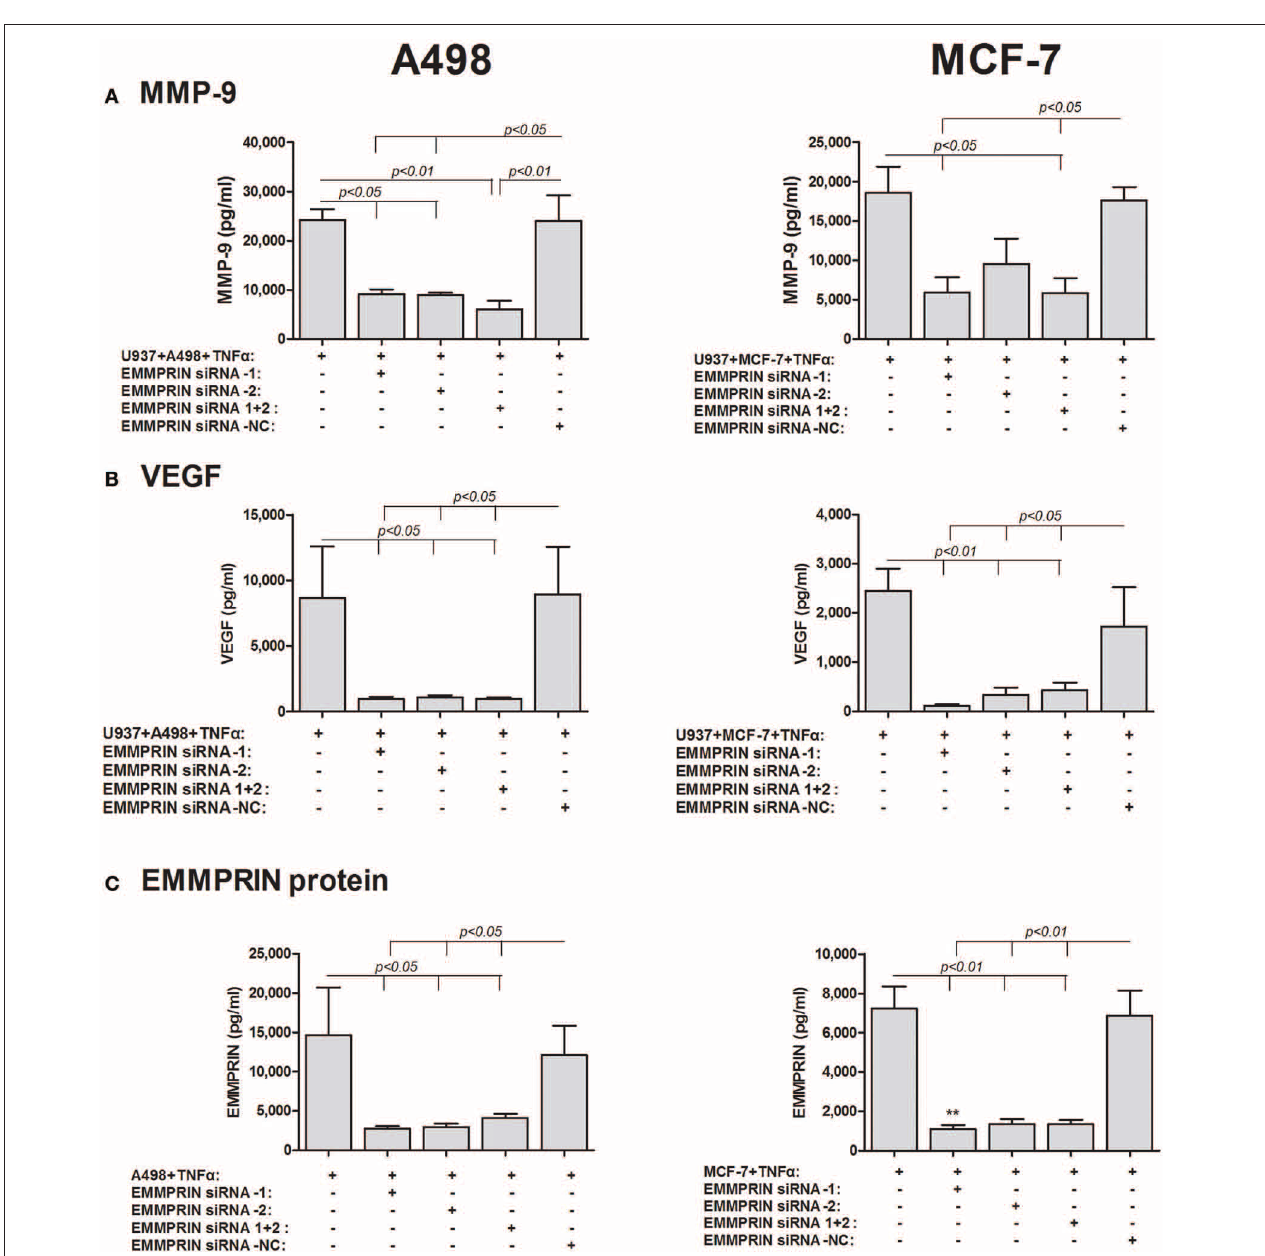
FIGURE 6 | Effect of EMMPRIN siRNA on the secretion of MMP-9, VEGF and EMMPRIN. 0 . 6 × 10 5 A498 or MCF-7 cells were incubated separately or in co-cultures with 0 . 3 × 10 6 U937 cells in a serum-free medium supplemented with TNF α (1ng/ml) for 48h. Tumor cells were first transfected